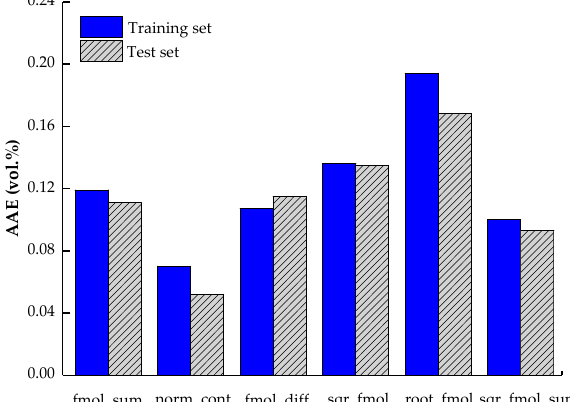
Figure 1. Experimental and predicted lower flammability limit (LFL) values for methane/butylene mixtures.